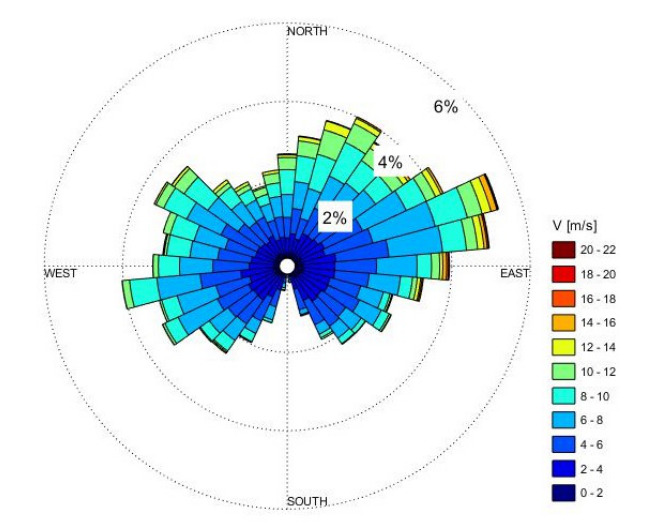
Figure 14. Wind power plant FW3 wind rose.